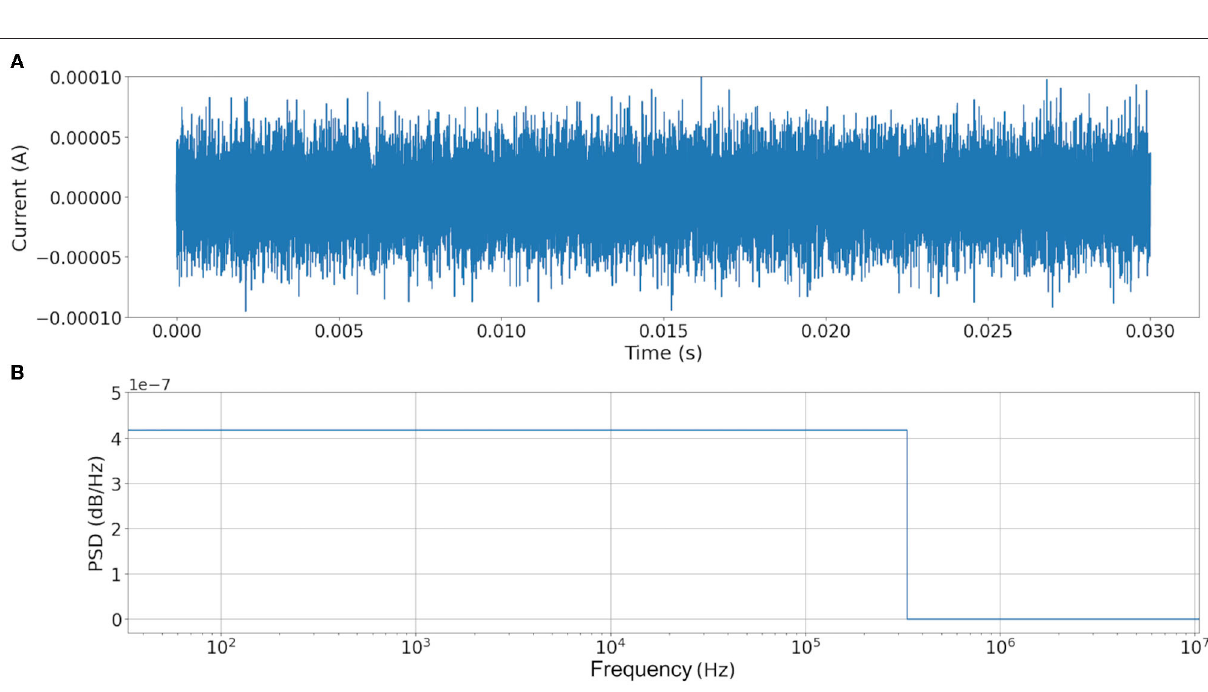
Frontiers in Neurorobotics | www.frontiersin.org 5 June 2022 | Volume 16 | Article